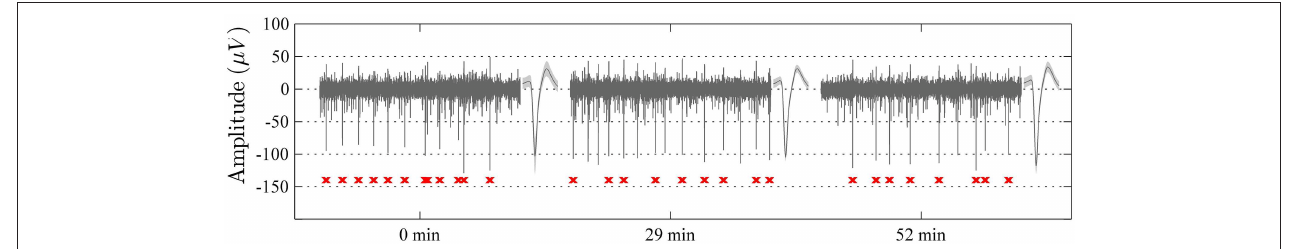
FIGURE 4 | Samples of 1s long recordings extracted at 0, 29, and 52min from one electrode channel in an awake non-restrained rat. The unit spike with the highest signal to noise ratio in each segment is shown to the right of respective sample (mean waveform ± standard deviation). Note the high level of stability of the recordings with respect to spike-waveforms (waveform correlation > 0.99 between the indicated unit waveforms of all three segments) and amplitude, as well as the overall recording qualities. The spike-times of the indicated single-unit are marked in red below the sweeps.